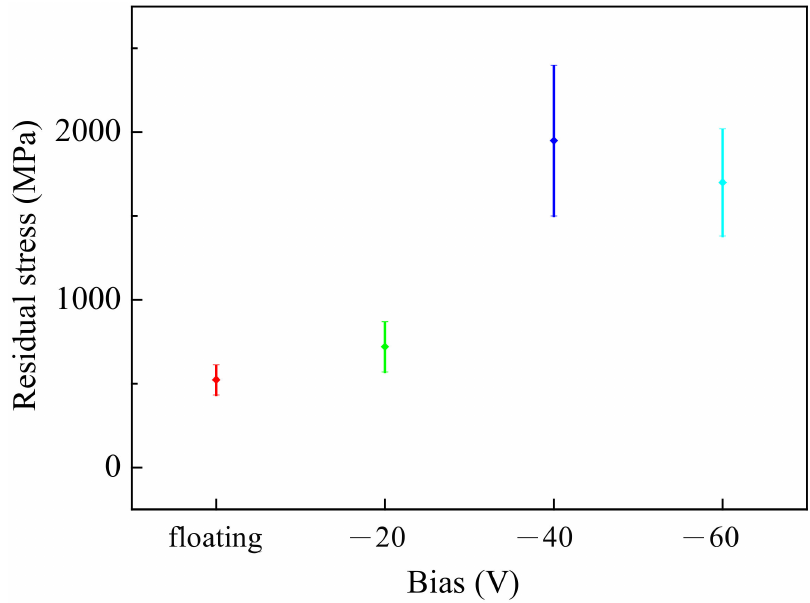
Figure 10. XRD analysis to measure the residual stress resulting from different bias